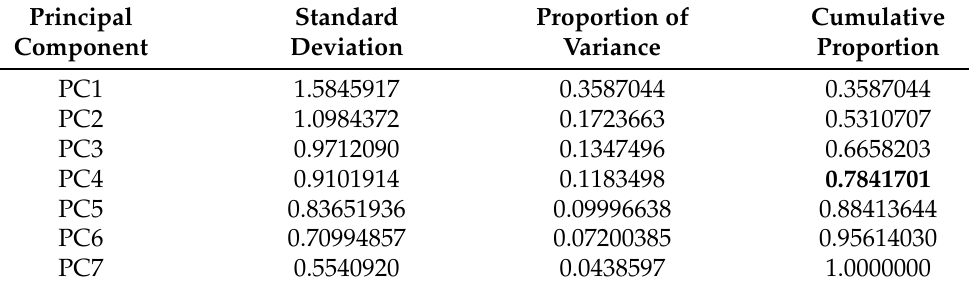
Figure 9. Scree plot of user experience factors. Of the seven identified principal components (PC1, . .., PC7 in Table 3), the first four account for more than 78% of the total variability. Table 3. Principal component analysis of the user experience factors. Bold represents cumulative proportion that is considered